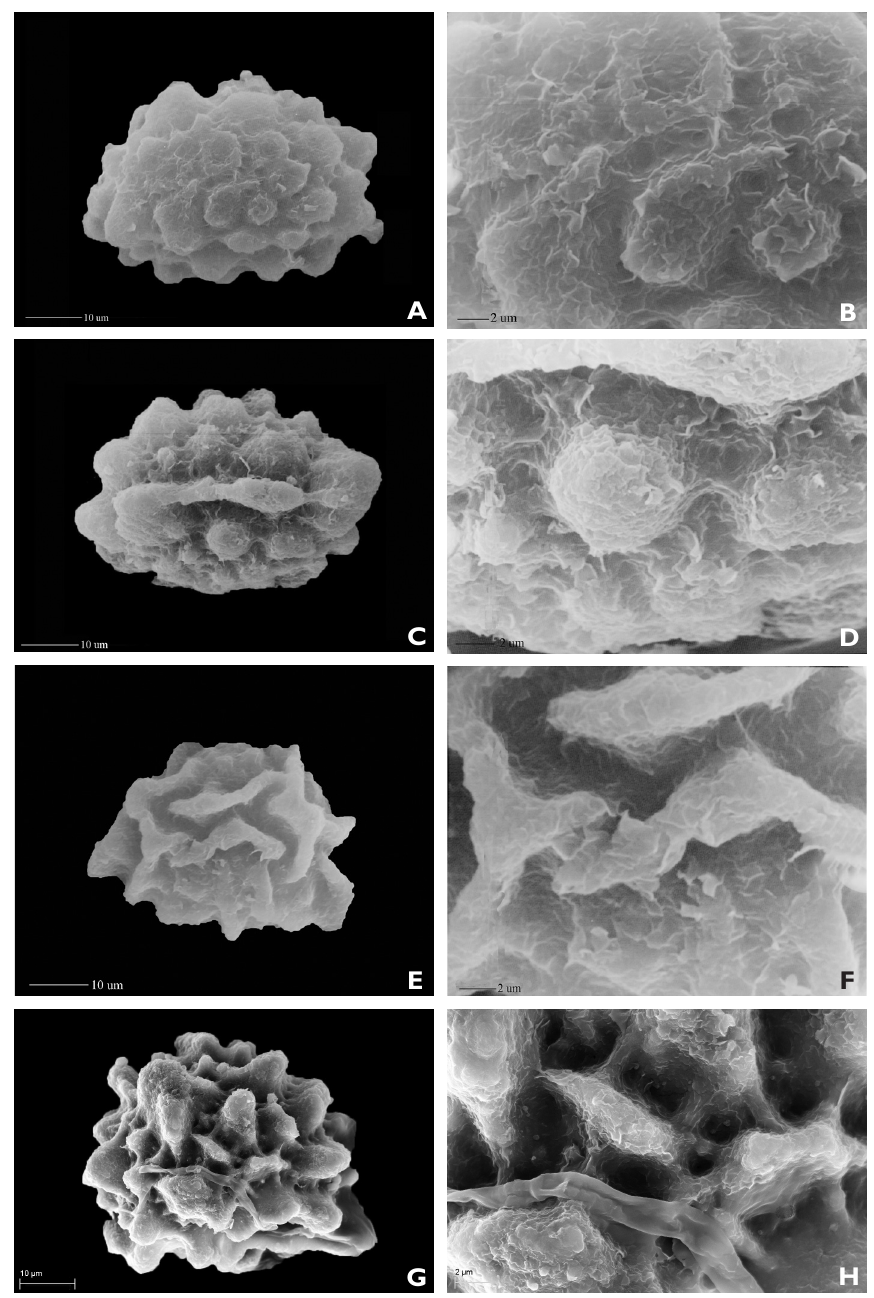
Figure 2. Spore morphologies of three Hypodematium species (SEM). A Spore in equatorial view of H. confer- tivillosum (1500×) B Detail of spore in equatorial view of H. confertivillosum (5000×) C Spore in polar view of H. confertivillosum (1500×) D Detail of spore in polar view of H. confertivillosum (5000×) E Spore in equatorial view of H. crenatum (1500×) F Detail of spore in equatorial view of H. crenatum (5000×) G Spore in equatorial view of H. glanduloso-pilosum (1500×) H Detail of spore in equatorial view of H. glanduloso-pilosum